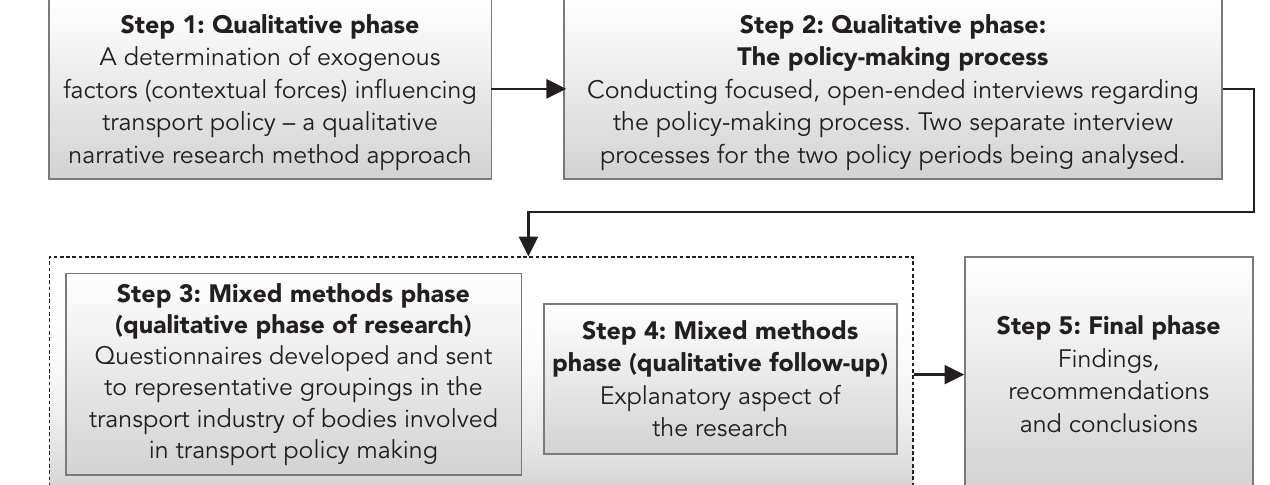
Figure 1: Steps in the research